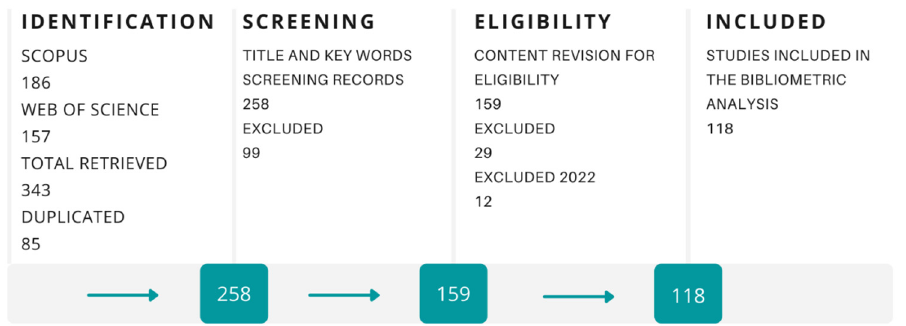
Figure 12. Literature review mechanism for natural fibers used in FDM.